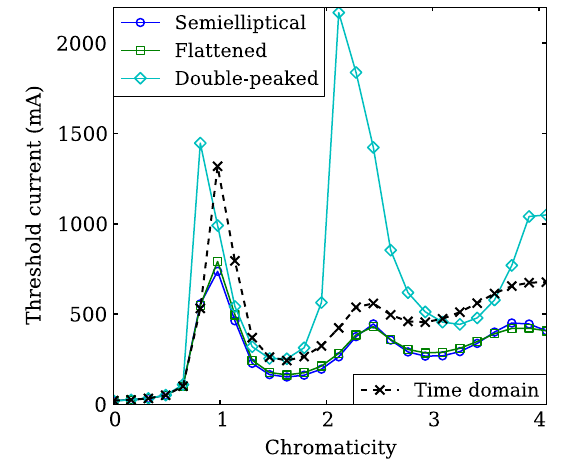
FIG. 16. Threshold current for the coupled-bunch resistive-wall instability for the case with a potential flattened with a harmonic cavity at the 11th harmonic of the main rf. Results of macro- particle simulations in the time domain (dashed line) are compared with those obtained using a frequency domain com- putation (solid